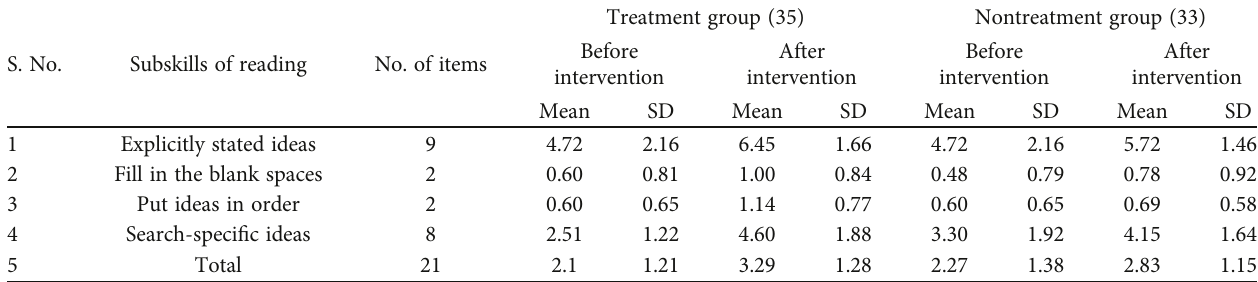
T ABLE 5: Comparison of the mean scores of the nontreatment and treatment groups on questions that require a lower level of thinking.